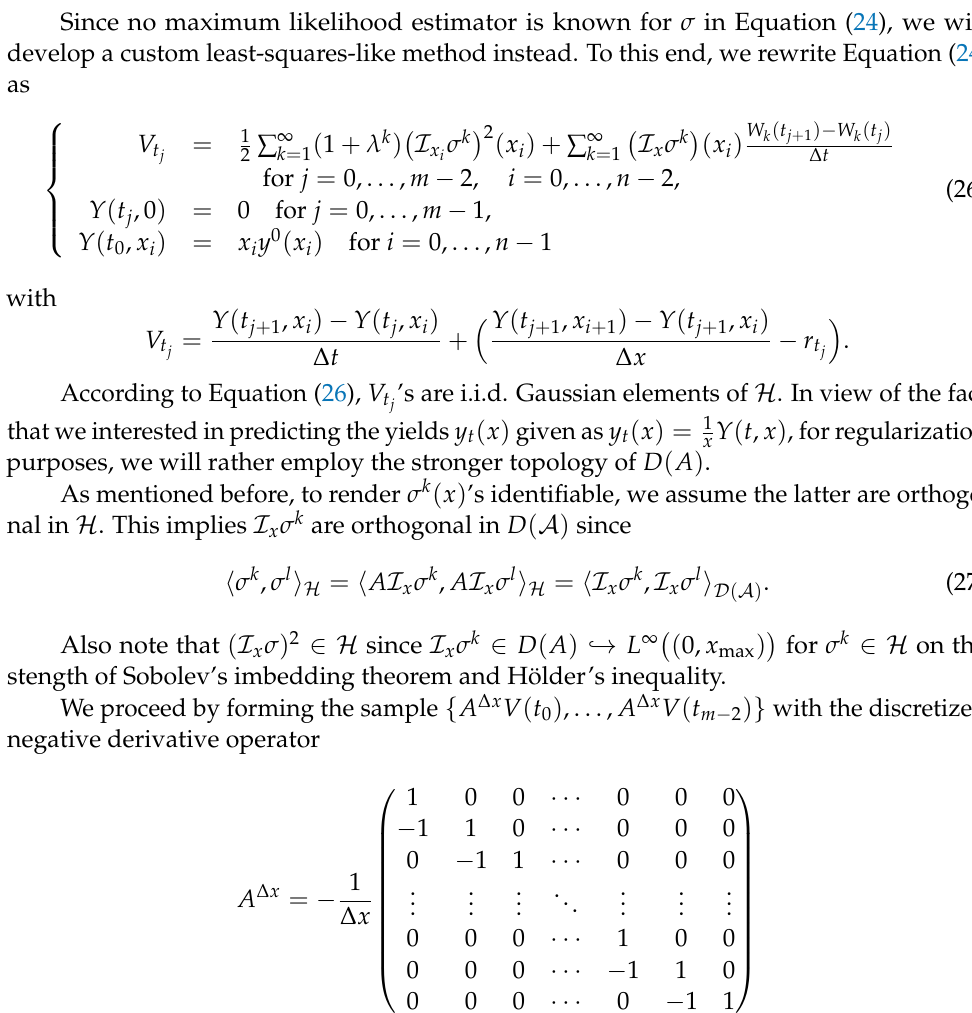
Table 1. ML estimates for the Vasicek model based on 2018 historic short rate data. ˆ α ˆ r ∗ ˆ β 0.079473 − 0.63952